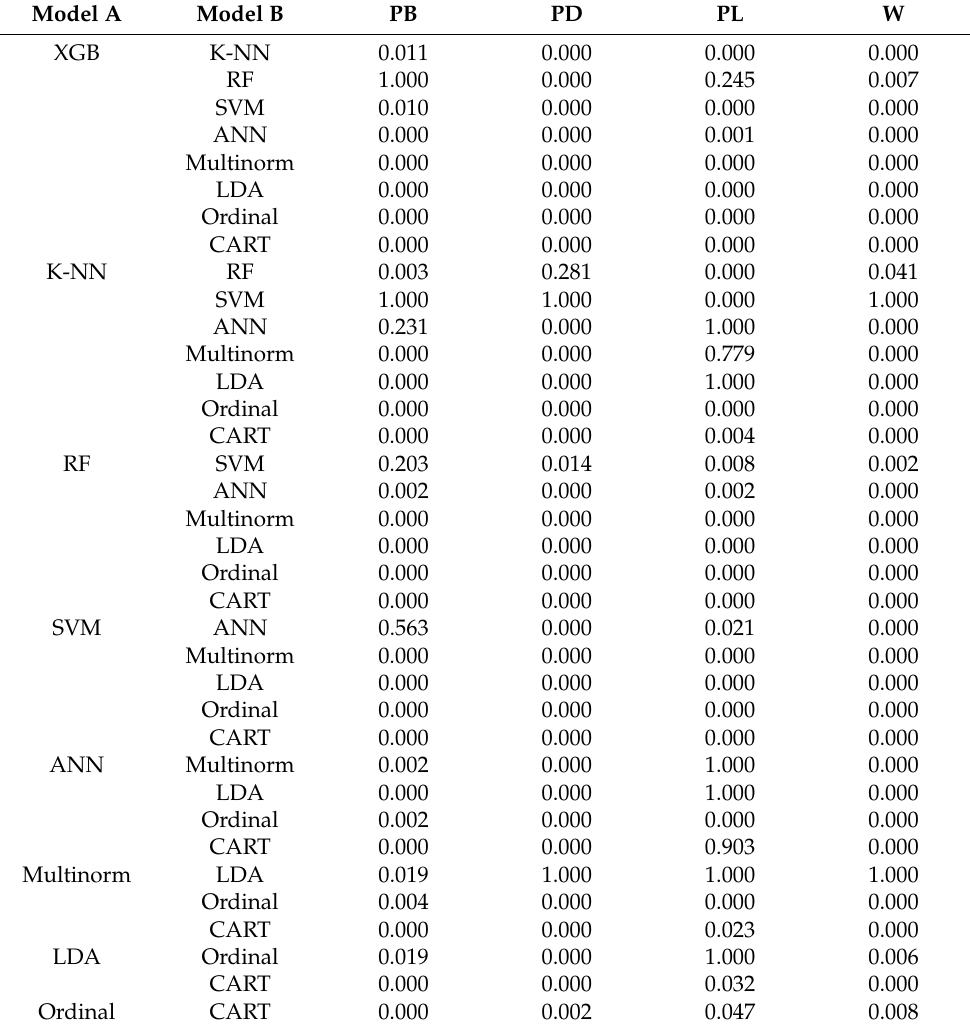
Table A2. A pairwise comparison (Bonferroni p -value adjustment) of overall performance accuracy of nine predictive models for BCS, at different stages of the annual cycle (PB: pre-breeding, PD: pregnancy diagnosis, PL: pre-lambing, W: weaning) in 43–54-month-old ewes. p -value > 0.05 indicates no significant difference between models. All ewe BCS predictions were based on liveweight record 2.